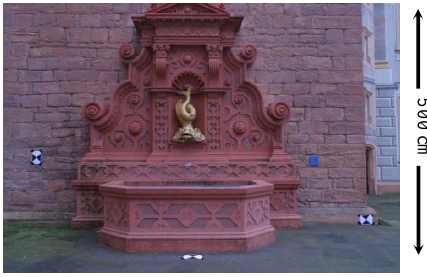
Figure 3: Real image of the